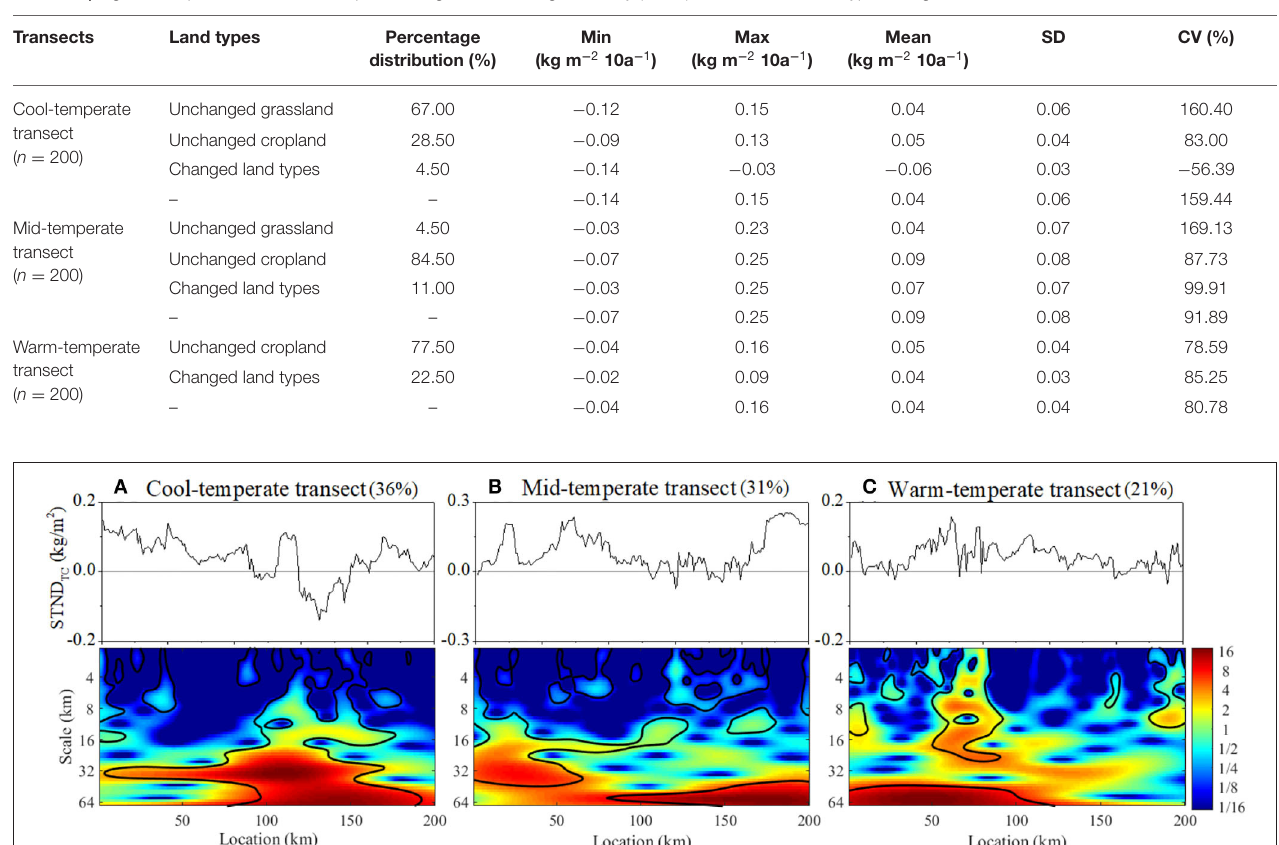
FIGURE 2 | The spatial distribution of temporal change of soil nitrogen density (SND T ) and the local wavelet spectra of SND T along the (A) cool-temperate, (B) mid-temperate, and (C) warm-temperate transects. The solid black lines in the local wavelet spectra show SND T variation with > 1 standard deviation, and the numbers in the bracket represent the area of significant variations.